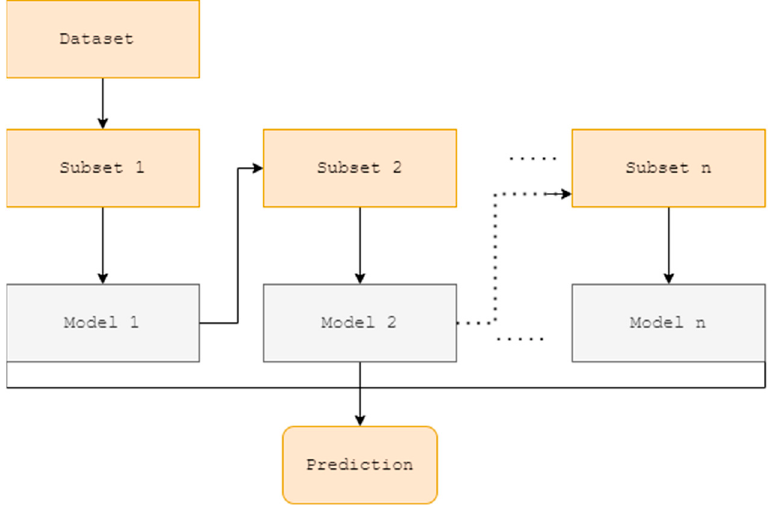
Figure 4. Schematic diagram of the AdaBoost Regressor.